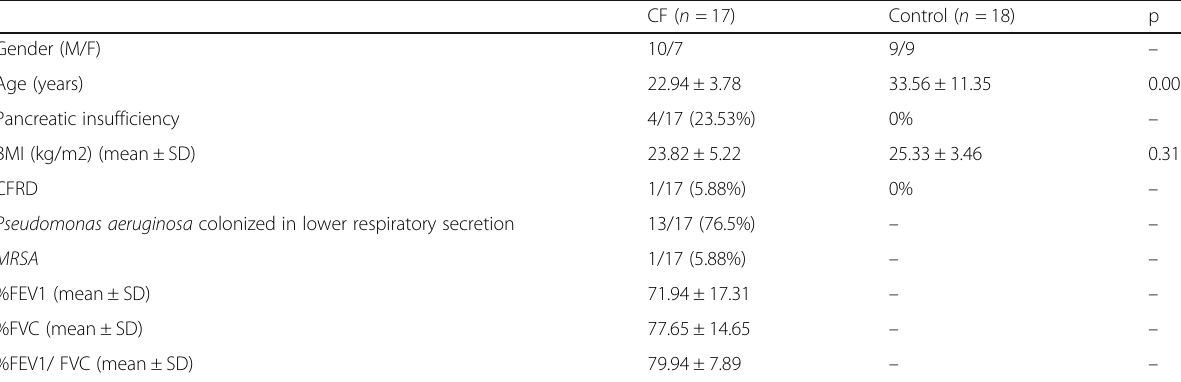
Table 1 Demographic and clinical data of CF and control